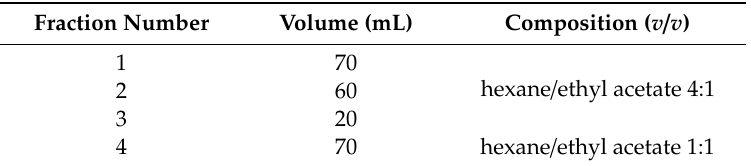
Table 1. Volume and composition of the various solvent fractions used in the first separation of the components existing in the ginger extract.